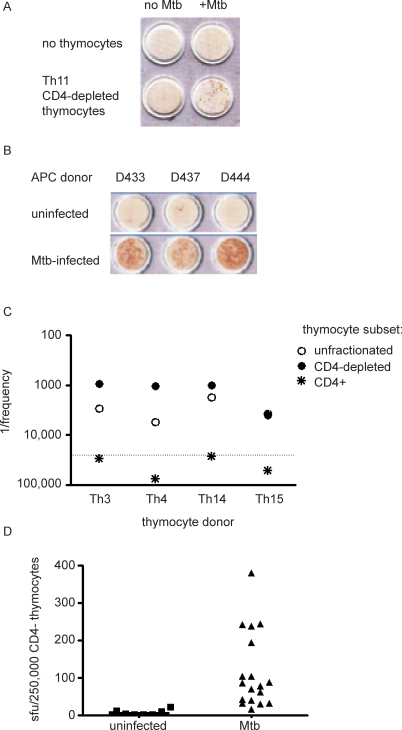
Mtb-Reactive CD4− Thymocytes Are Present in the Human Thymus(A) CD4-depleted thymocytes from thymocyte donor 11 (750,000/well) were incubated overnight with autologous DC (20,000/well) that were either infected with Mtb (moi of 50) or left uninfected.(B) Thymocytes (250,000 cells/well) from one thymocyte donor were incubated with MHC mismatched DC (50,000 cells/well) from 3 different donors.(C) Thymocytes from 4 individual donors were left unfractionated, or fractionated based on the positive or negative expression of CD4 using CD4 magnetic bead separation and incubated overnight with Mtb-infected DC (50,000/well). The dotted line represents the limit of detection of the assay. The lack of Mtb-reactivity from the CD4+ thymocytes fraction has been reproducible and repeated with over 10 donors.(D) CD4-depleted thymocytes (500,000/well) were titrated in a series of 2-fold dilutions and incubated with Mtb-infected DC (50,000/well). Frequencies were determined by linear regression analysis as described in Materials and Methods. In all experiments, IFN-γ production was assessed by ELISPOT. Mtb-reactive thymocytes (n = 18) ranged from 16.5 to 381 spot-forming units (sfu)/250,000 CD4− thymocytes with a mean of 115.9 ± SD 101.2.